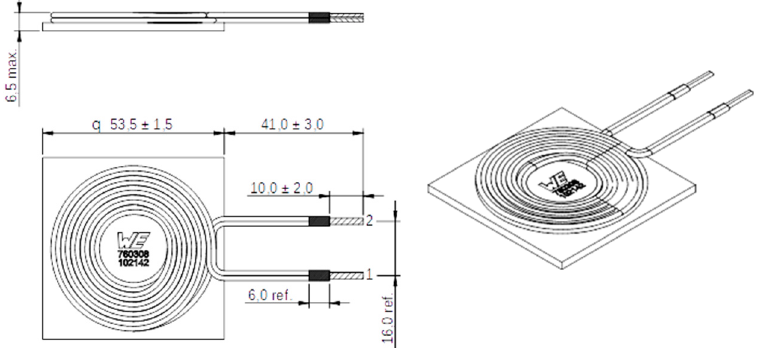
Figure 7. Dimensions (mm) of the commercial off the shelf (COTS) coils used in the design (Würth Elektronik 760308102142). Table 1. Coil selection and